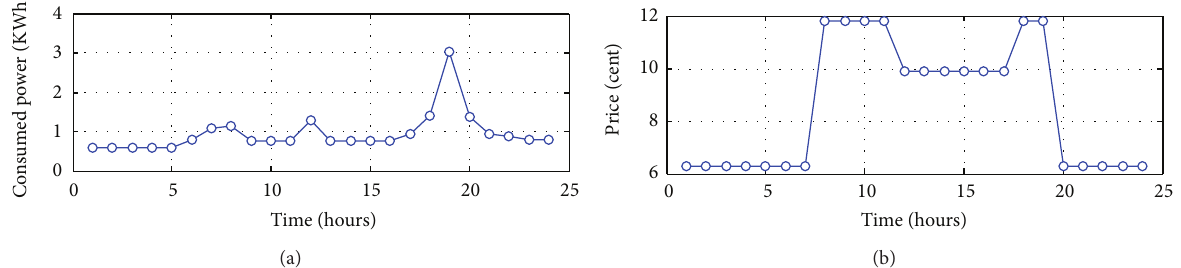
Figure 5: (a) Typical household electricity consumption pattern. (b) Typical hourly power price [14].